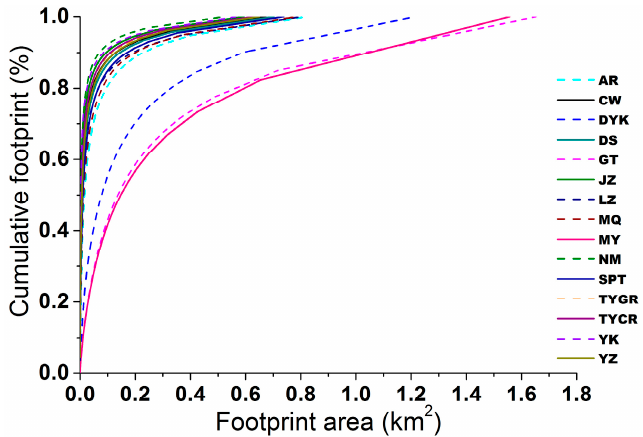
Figure 4. Cumulative footprint and their corresponding areas for the 15 eddy covariance (EC) sites.